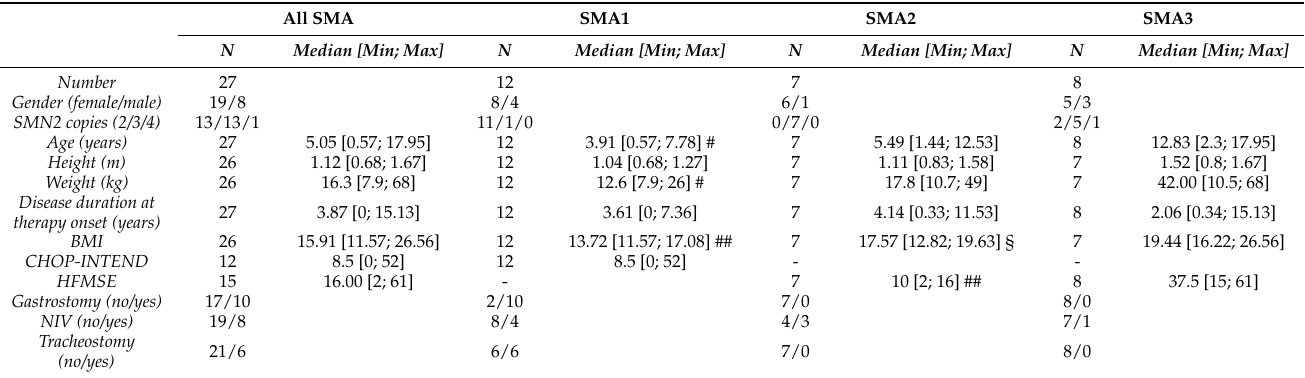
Table 1. Demographic and clinical characteristics of SMA